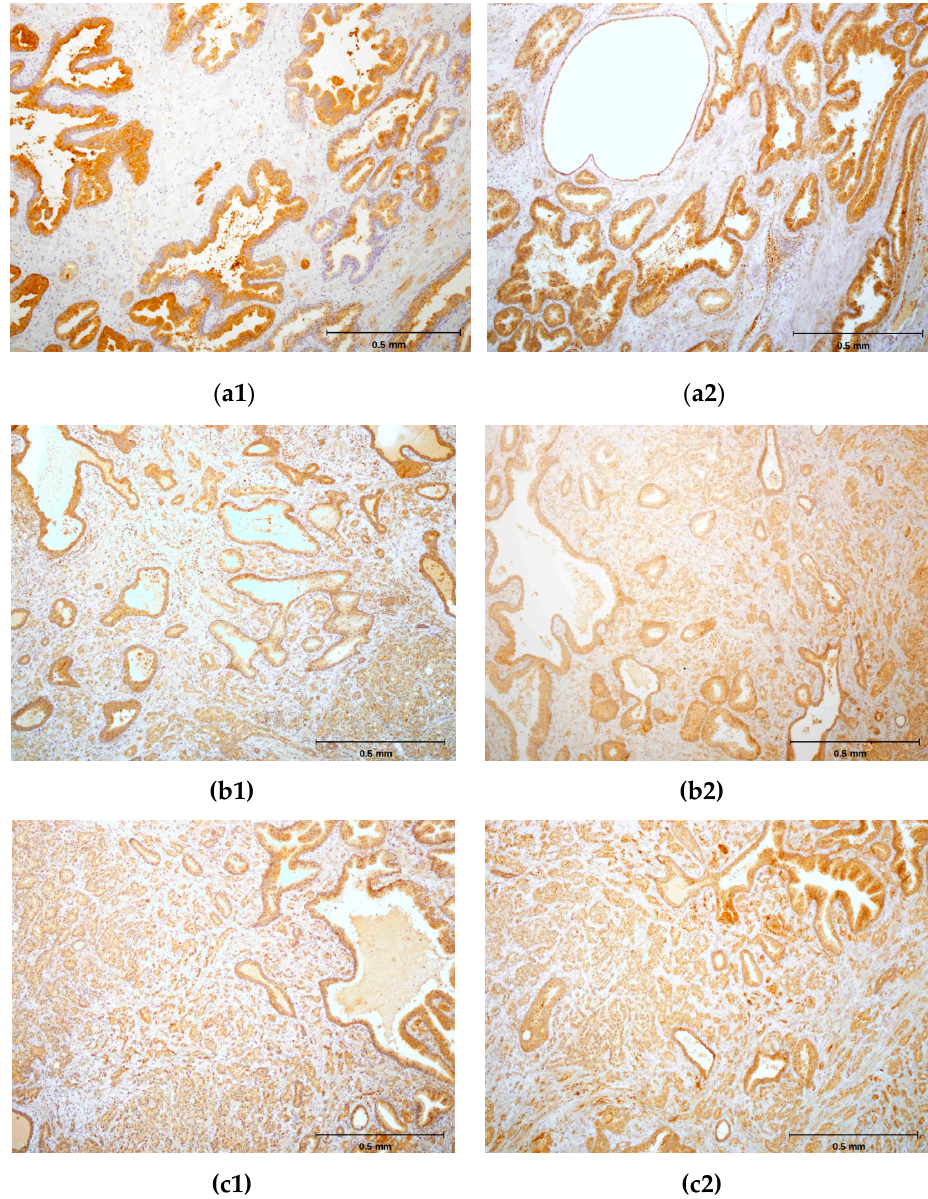
Figure 6 . ( a1 , b1 , c1 ) Immunohistochemical staining of three different hPSA tissue samples with standard monoclonal antibody ER-PR8 (dilution 1:100). ( a2 , b2 , c2 ) Immunohistochemical staining of three different hPSA tissue samples with biotinylated antisense peptide AVRDKVG (dilution 1:100). The black line in the lower right corner denotes the scale bar (0.5 mm).